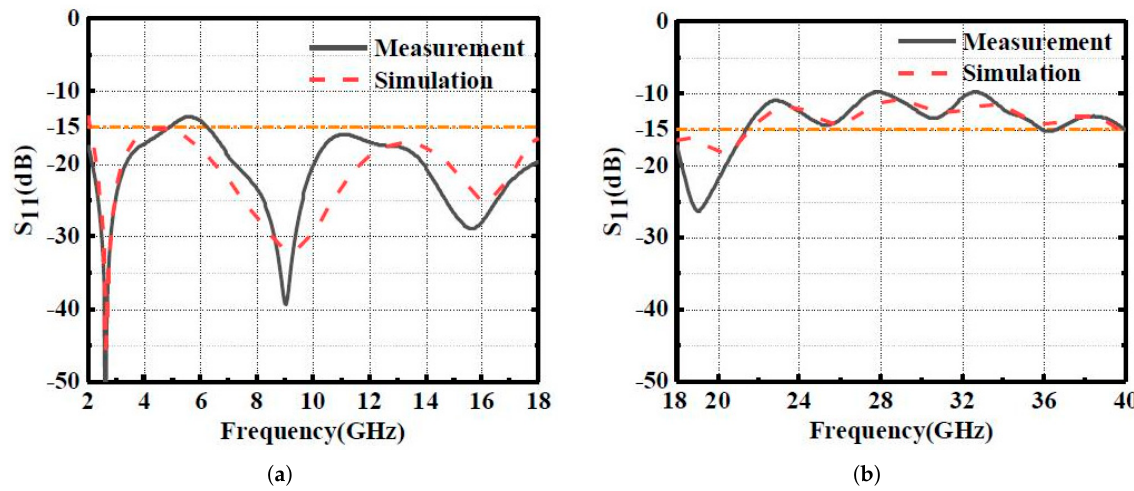
Figure 9. Measurement S 11 ( a ) 2 − 18 GHz. ( b ) 18 − 40